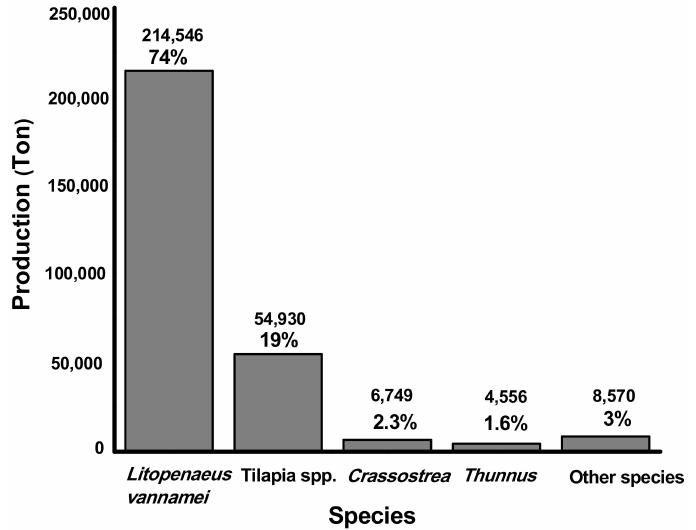
Figure 1. Main species cultivated in Mexico under controlled systems